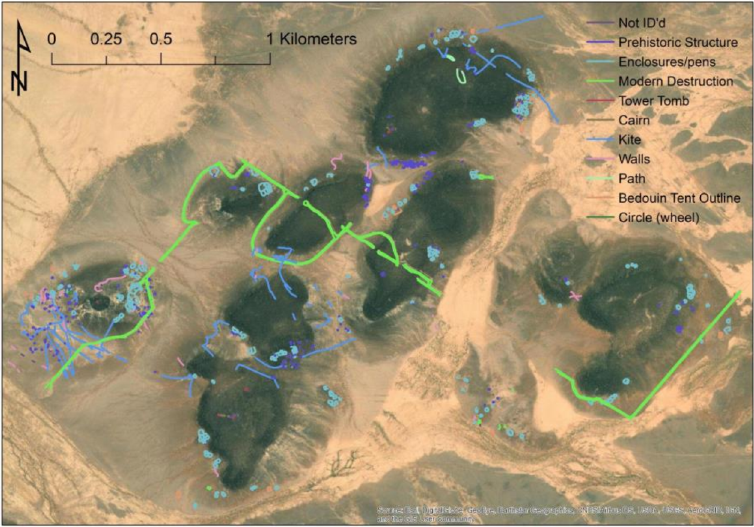
Figure 10. Closeup of all identified features in the northern end of the survey region. Basemap source: Esri, DigitalGlobe, GeoEye, Earthstar Geographics, CNES/Airbus DS, USDA, USGS, AeroGRID, IGN, and the GIS User